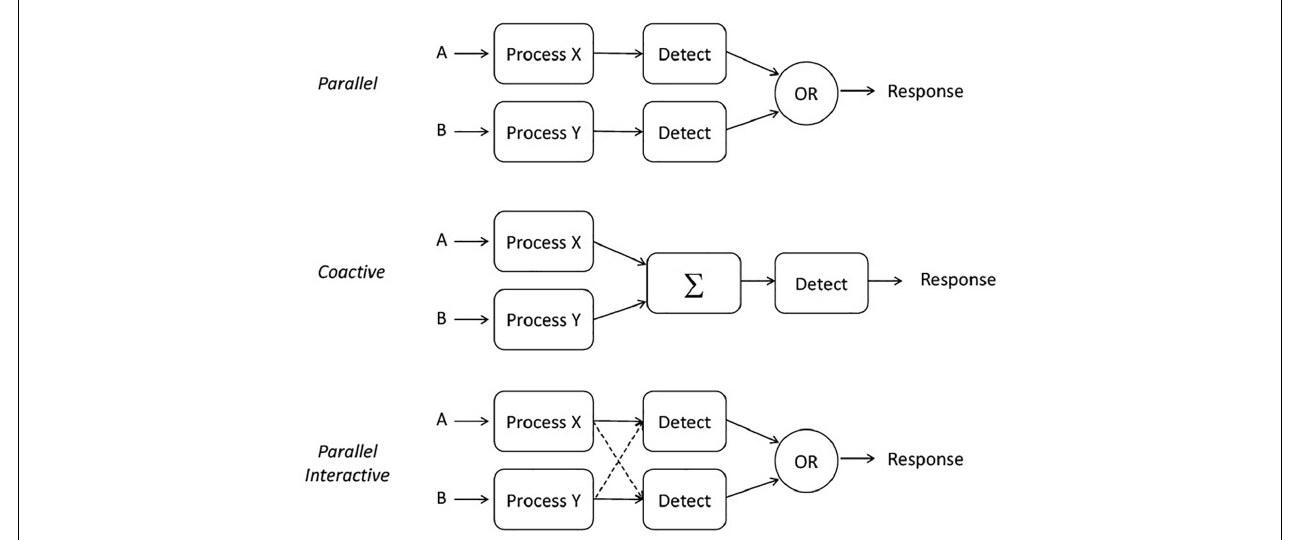
FIGURE 1 | Illustration of three potential architectures: parallel, coactive, and parallel